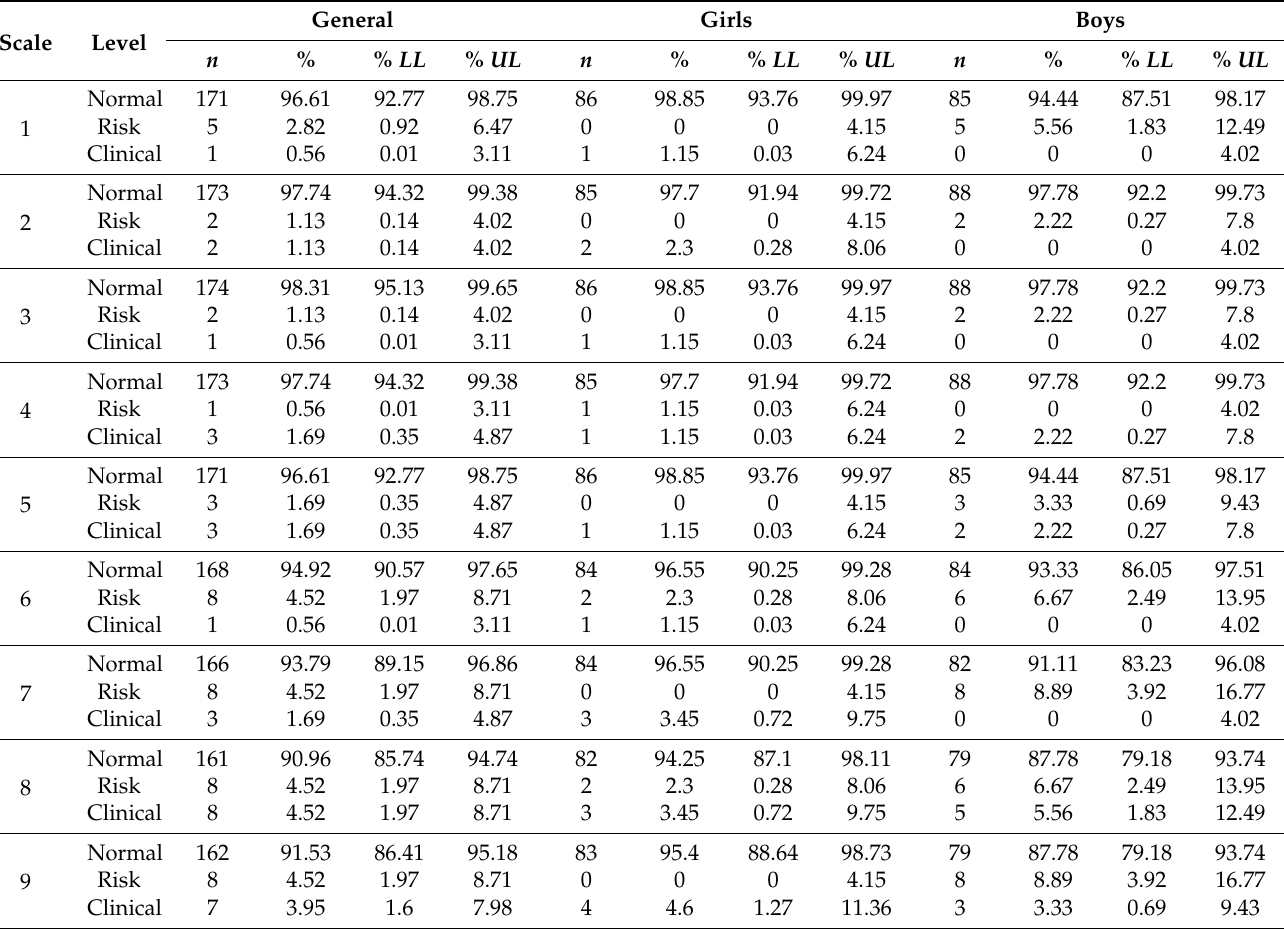
Table 5. Prevalence of syndrome scales of the